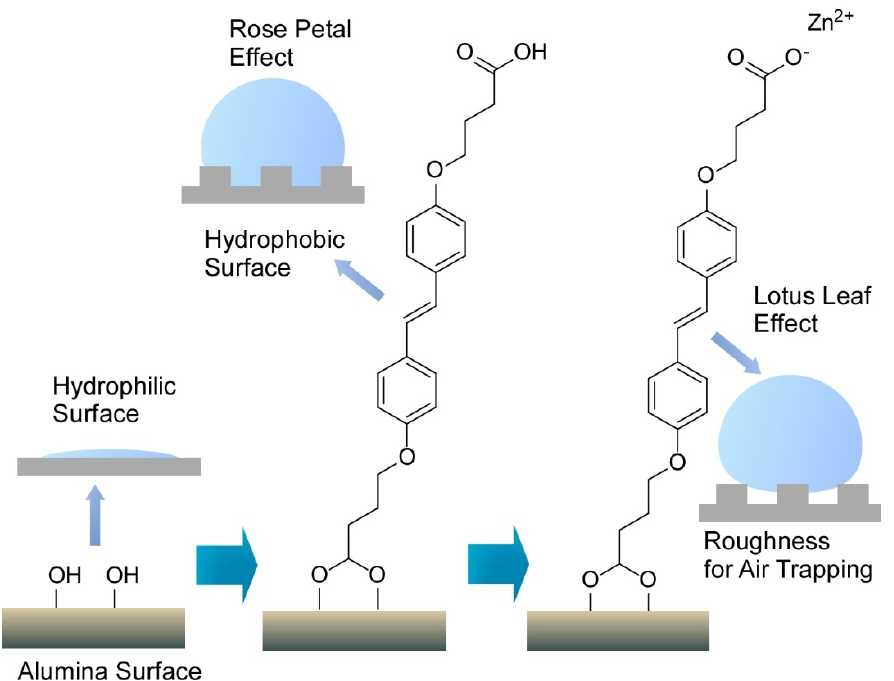
Figure 14. Surface nanoarchitectonics of conventional alumina materials to regenerate bio-like wettability functions of rose petal and lotus leaf effects where single molecule in assembled structure is only depicted.